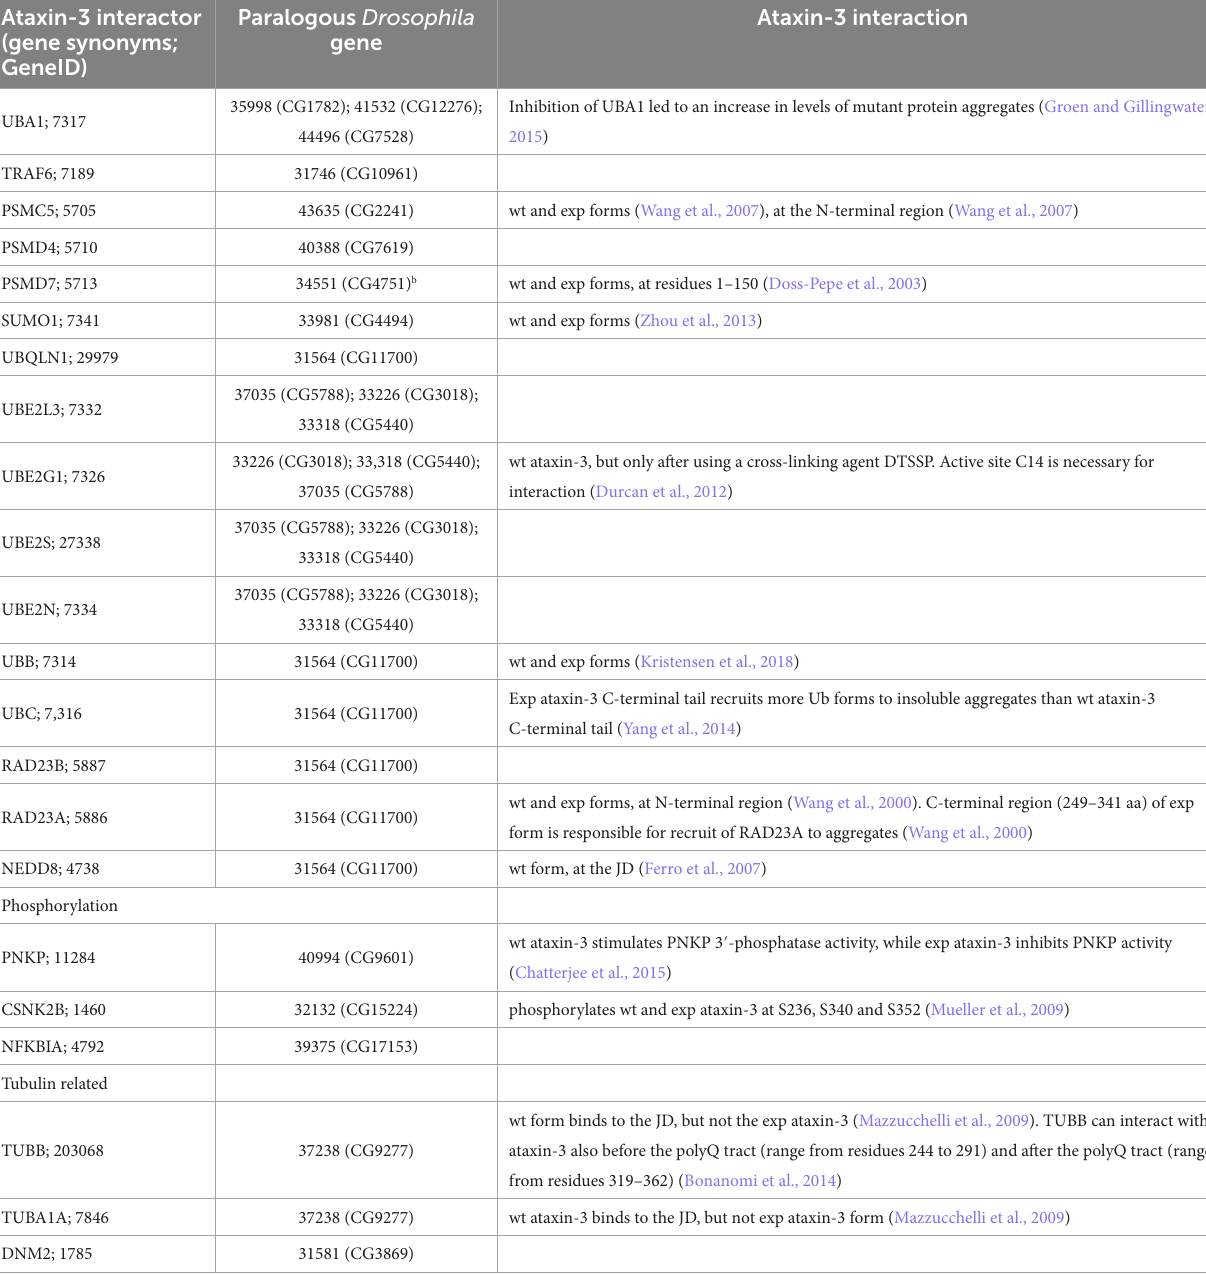
acid site at the human ataxin-3, when considering human (N = 117) and fly (N = 37) interactors. When considering the interactors that present a larger number of interaction regions outside the JD region, occupancy frequency of each ataxin-3 residue, in Drosophila and Homo , respectively; Figure 3B) between usage (in percentage) of an amino acid site at the human ataxin-3 when considering human (N = 15) and fly (N = 5) interactors, despite the small sample size. Since the JosL fly interactors show a similar behavior to the human ataxin-3 interactors, mutant ataxin-3 flies are good models for